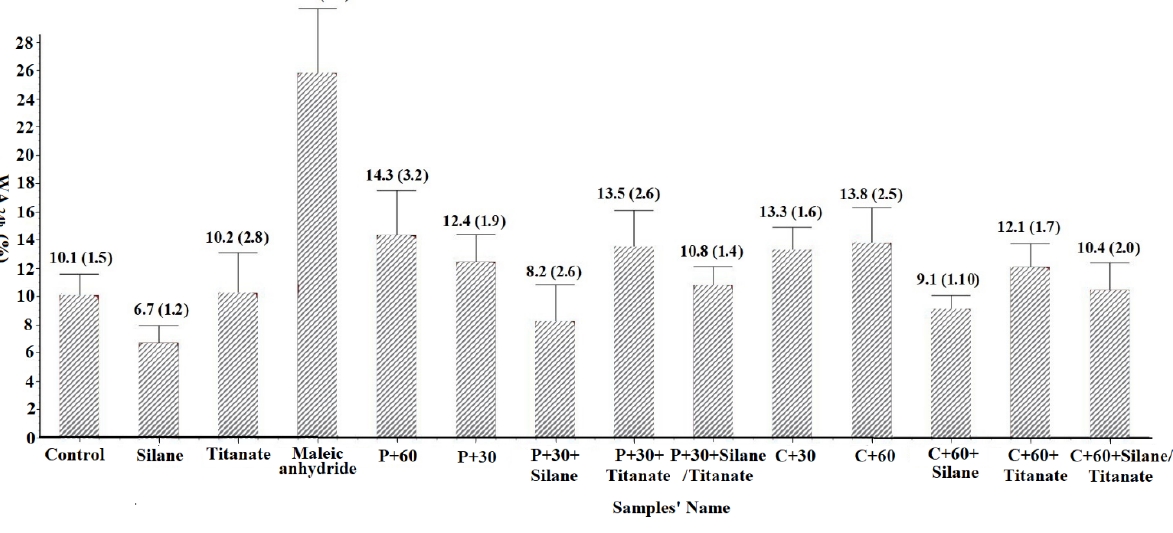
Figure 4. Elastic modulus of composites (MOE) (Values represent means of 10 replicates/test. Values in parentheses rep- resent one standard deviation; the detail for samples’ name shown in Table 1).